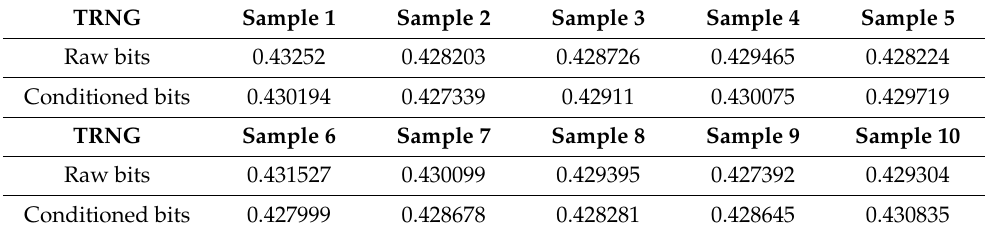
Table 6. Min entropy of the raw and conditioned true random bits.